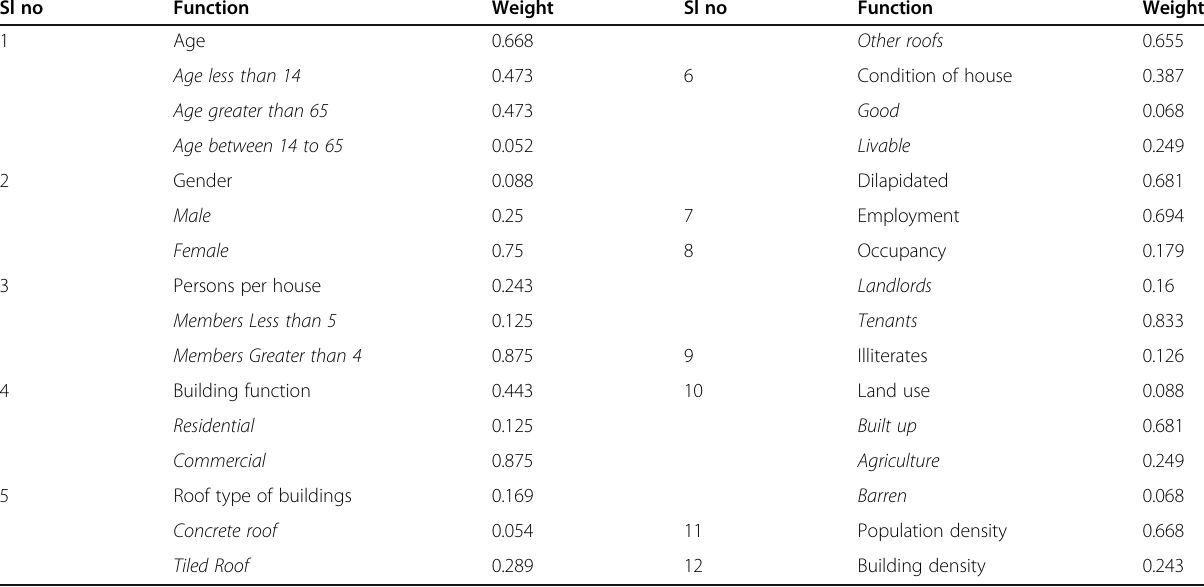
Table 2 Weight for Socio-economic vulnerability